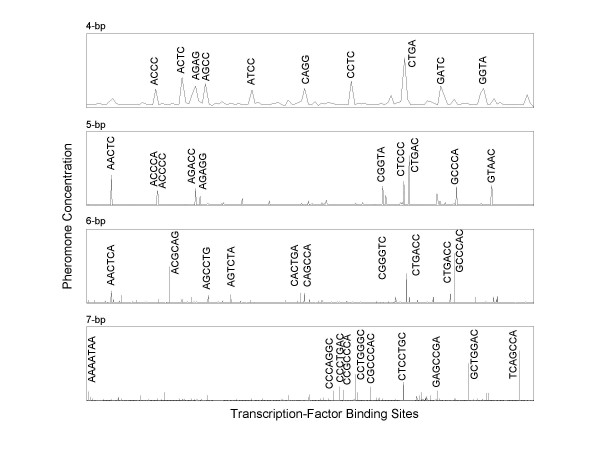
Motif length analysis. The motif length analysis among the four models (4-, 5-, 6-, and 7-bp DNA sequences as potential transcription-factor binding motifs) with ε = 10 and δ = 0.1. (A) Pheromone spectrum for 4-bp DNA sequences. (B) Pheromone spectrum for 5-bp DNA sequences. (C) Pheromone spectrum for 6-bp DNA sequences. (D) Pheromone spectrum for 7-bp DNA sequences.